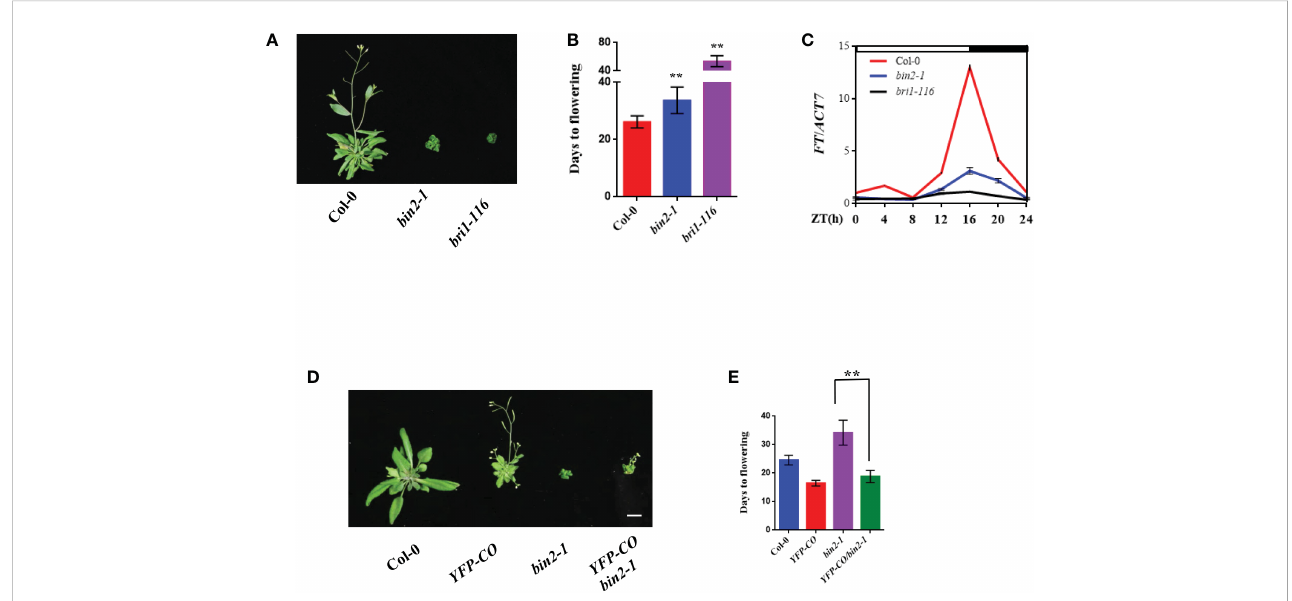
FIGURE 2 BR negatively regulates fl owering time genetically upstream of CO. (A) Flowering phenotype of the indicated plants under LDs. Bar, 1 cm. (B) Days from germination to fl owering of plants shown in (A) . Asterisks indicate a signi fi cant difference according to Student ’ s t test (**, P <0.01), n > 20. (C) Diurnal expression pattern of FT in the indicated plants under LDs for 14 d. The mean values in Col-0 at Zeitgeber time (ZT) 0 were set to 1 (mean ± SD). White bars indicate day, and black bars represent night. (D, E) Genetic interaction assays between BIN2 and CO. Flowering phenotype of the indicated plants under LDs (D) . Days from germination to fl owering of indicated plants (E) . Asterisks indicate a signi fi cant difference according to Student ’ s t test (**, P <0.01), n > 20. Bar, 1